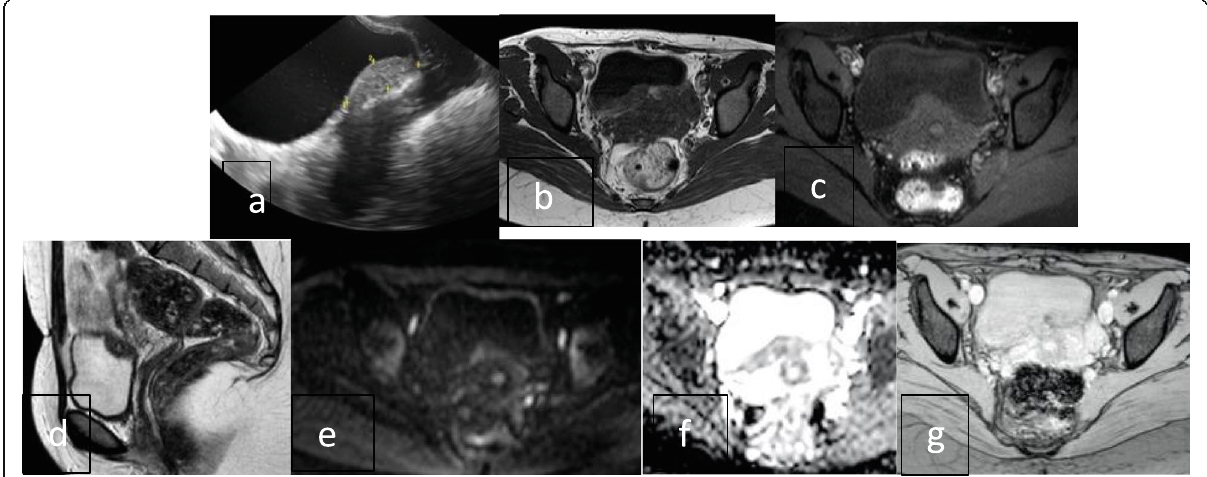
Table 3 Sensitivity, specificity, positive predictive value, negative predictive values of conventional MRI; DWI and signal void in T2* images Conventional MRI DWI with ADC maps Signal voids